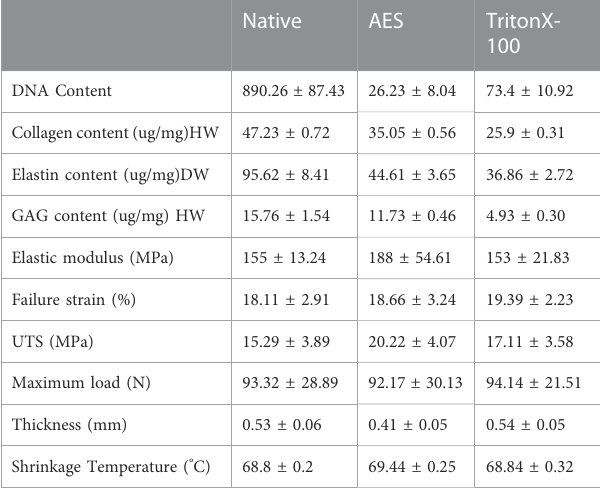
TABLE 1 Cell removal ef fi ciency and mechanical properties of each